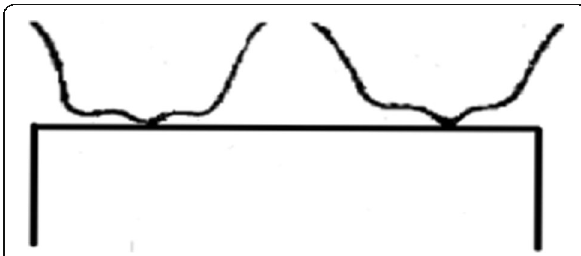
Fig. 1 An illustrative diagram of the surface discontinuities on the fingerprint ridge of a dry finger when nothing is applied over it